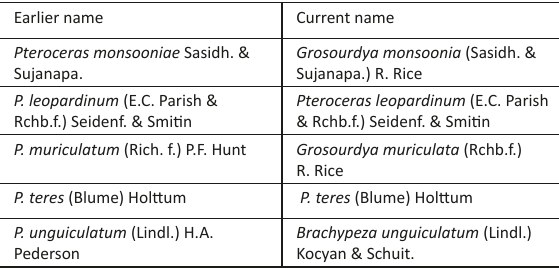
Table 1. Status of Pteroceras species found in India after modifications by (Rice 2018)